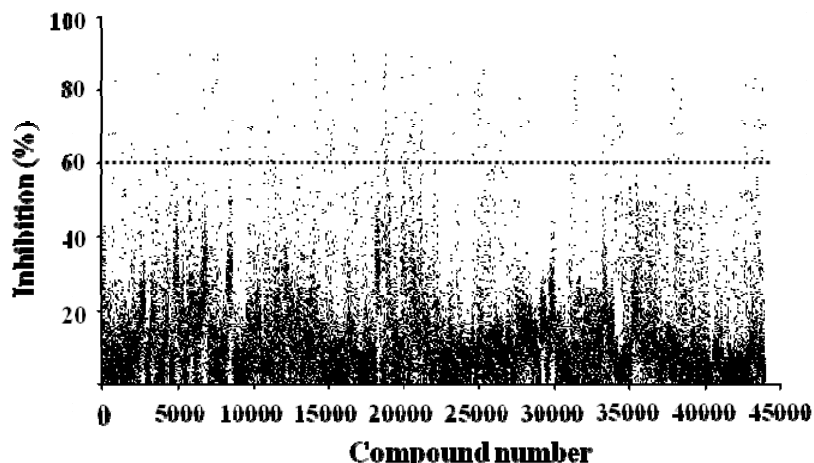
Figure 5. Summary of high-throughput screening of 40,960 compounds for inhibition of ADAMTS1 activity. Each dot represents one